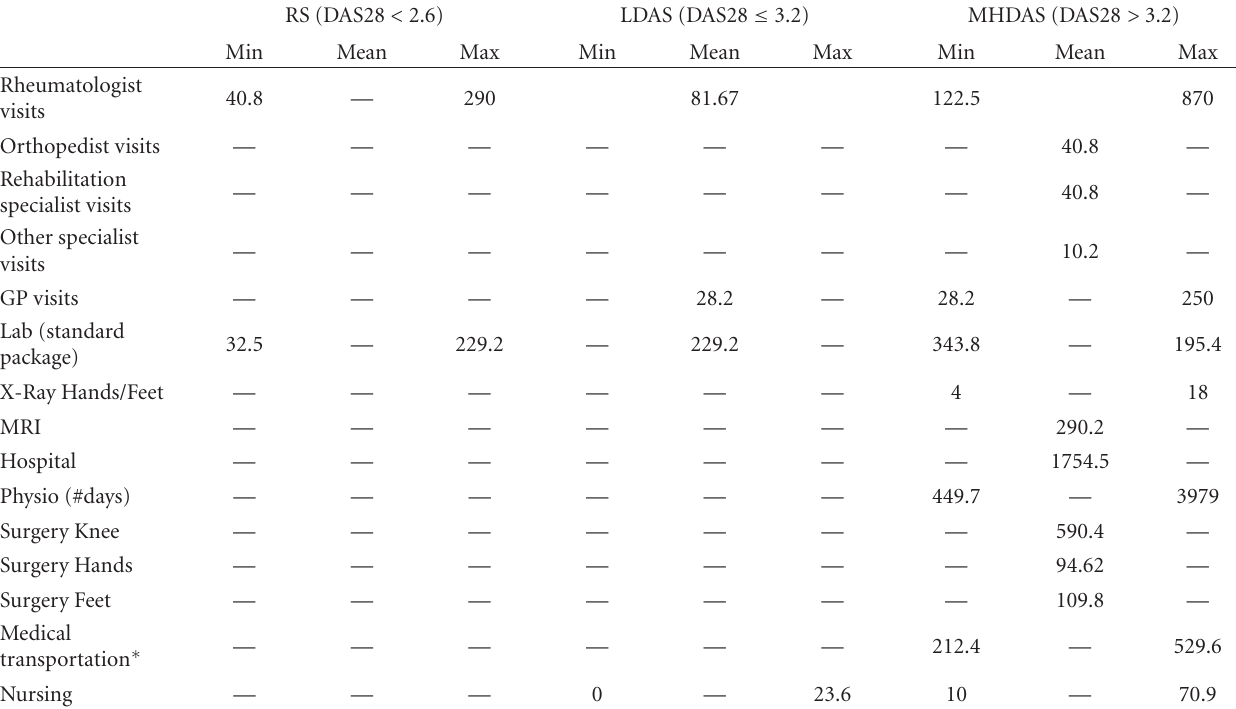
Table 1: Estimated medical resource utilization over 6 months per level of disease activity, excluding biological drug costs (in